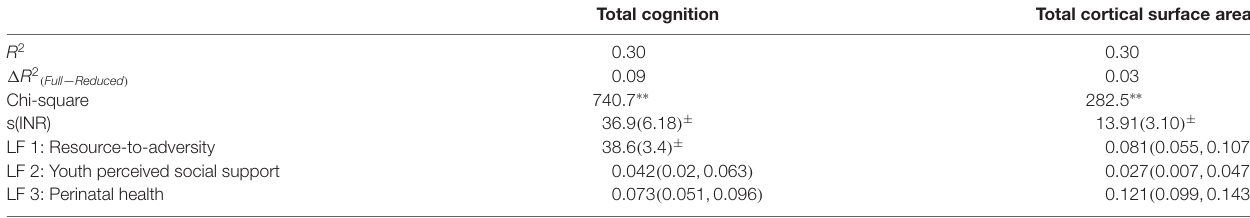
TABLE 3 | Standard beta coefficient values and 95% confidence intervals are shown for each latent factor, while for the smooth terms of the INR and LF1 (cognition model only) the F(edf) values are shown, for models in which the INR and latent factors were entered together as predictors of total cognition scores and total cortical surface area. The additional variance statistically attributable to this full model compared to a reduced model (covariates only) is shown as ∆ R 2